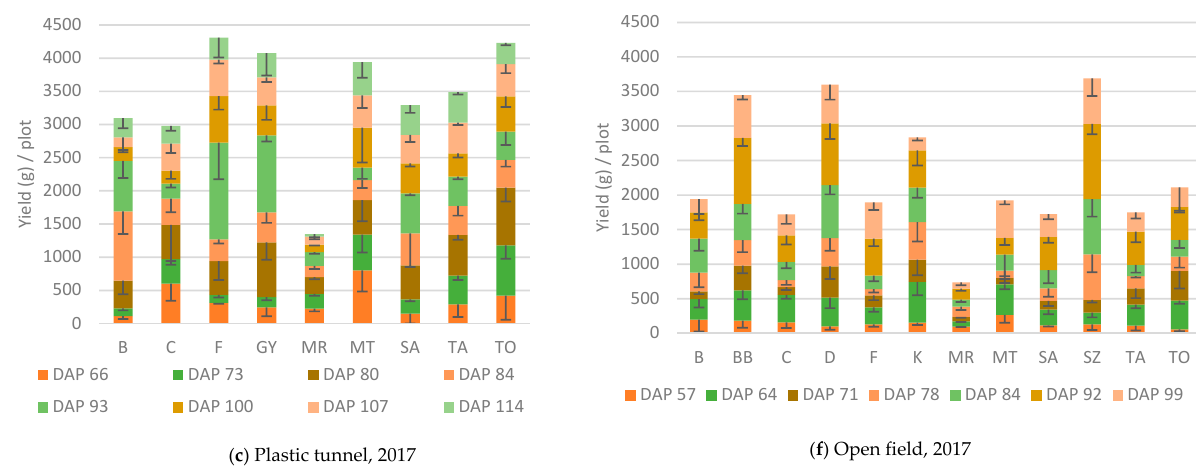
( c ) Plastic tunnel, 2017 ( f ) Open field, 2017 Figure 3. Average yield data per plot of the different tomato gene bank accessions and control varieties in plastic tunnel and on open field. Stacked columns are divided by day after planting (DAP); error bars are minus direction of standard deviation. B: ‘Balatonboglár’; C: ‘Cegléd’; F: ‘Fadd’; GY: ‘Gyöngyös’; MR: ‘Máriapócs’; MT: ‘Mátrafüred’; TA: ‘Tarnaméra’; TO: ‘Tolna megye’; SA: ‘San Marzano’ ; BB: ‘Balatonboglár’; D: ‘Dány’; SZ: ‘Szentl ő rinckáta’; K: ‘Kecskeméti 549’ . Control varieties are in bold.